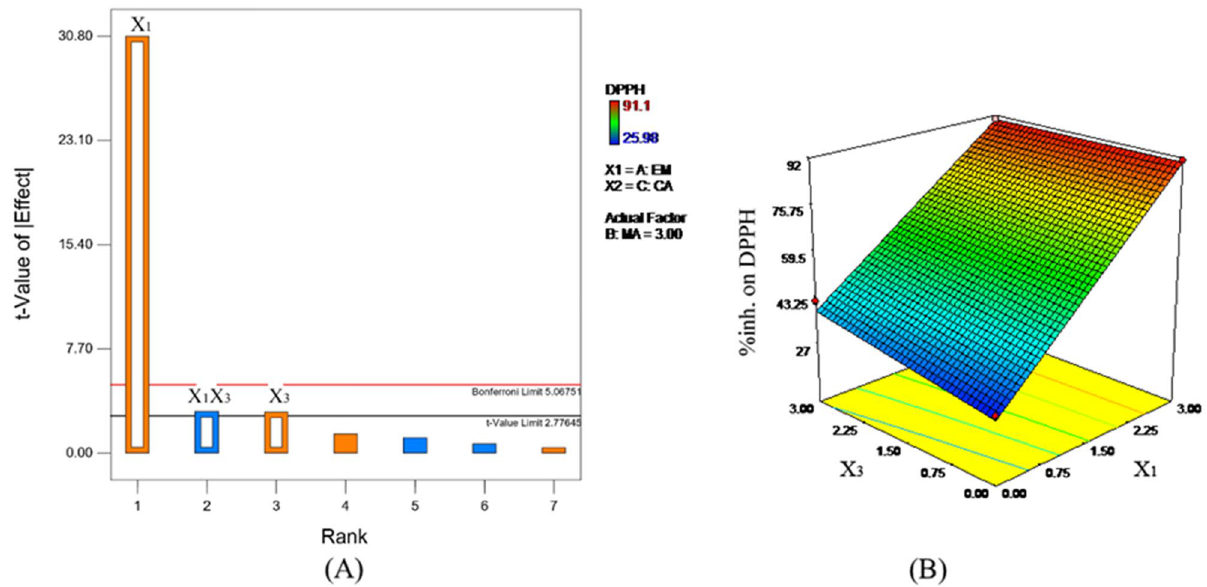
Figure 2. ( A ) Pareto charts illustrating absolute effects in a term of t-values on dependent variable as DPPH scavenging effect; ( B ) Response surface plots defining the combined effects of X 1 X 3 on DPPH radicals in which factor X 2 is